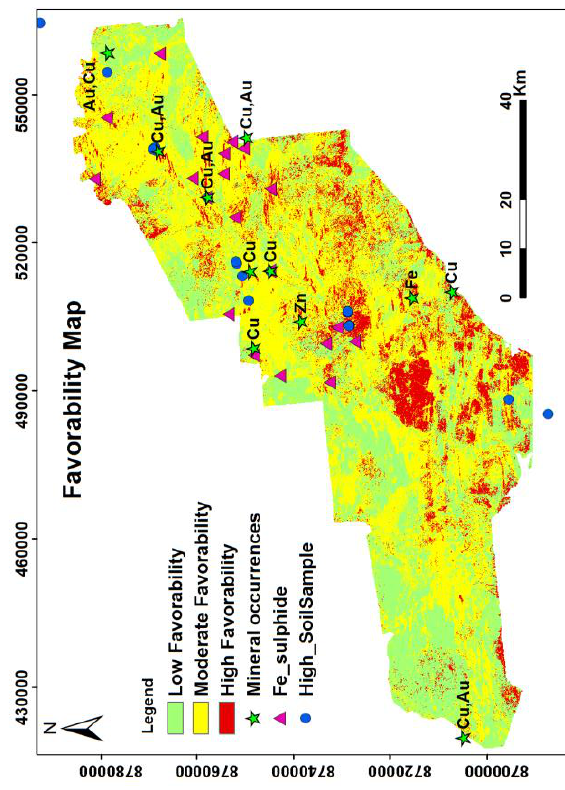
Figure 13. Favorability map based on applying the FAHP technique in the Inglefield